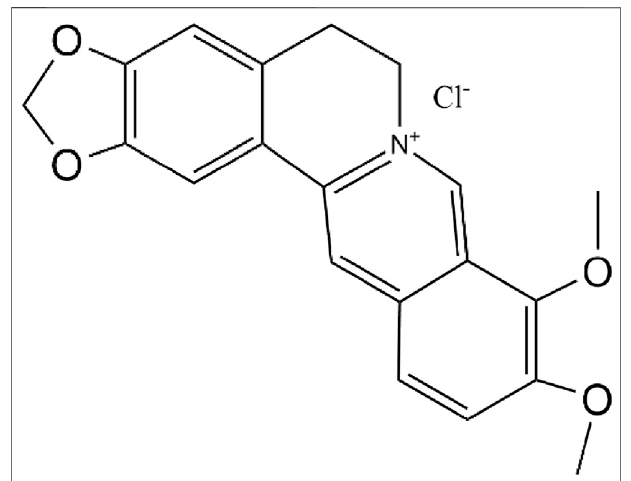
FIGURE 1 | The chemical structure of